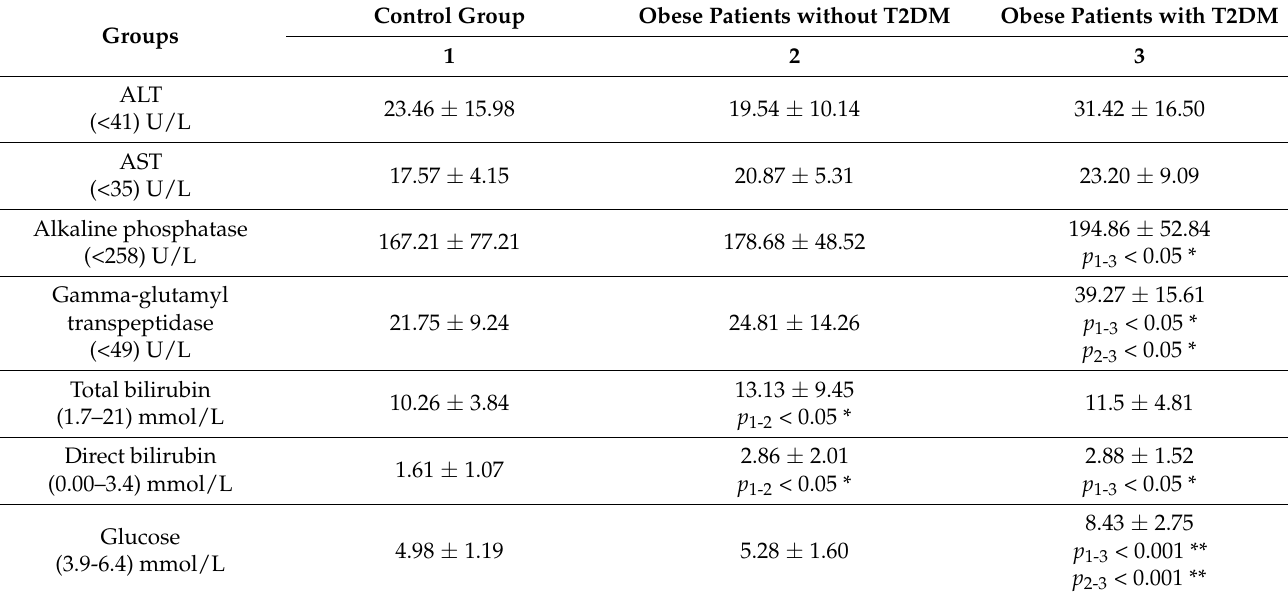
Table 2. Basic biochemical parameters of hepatic enzymes in the blood of obese patients with and without T2DM.